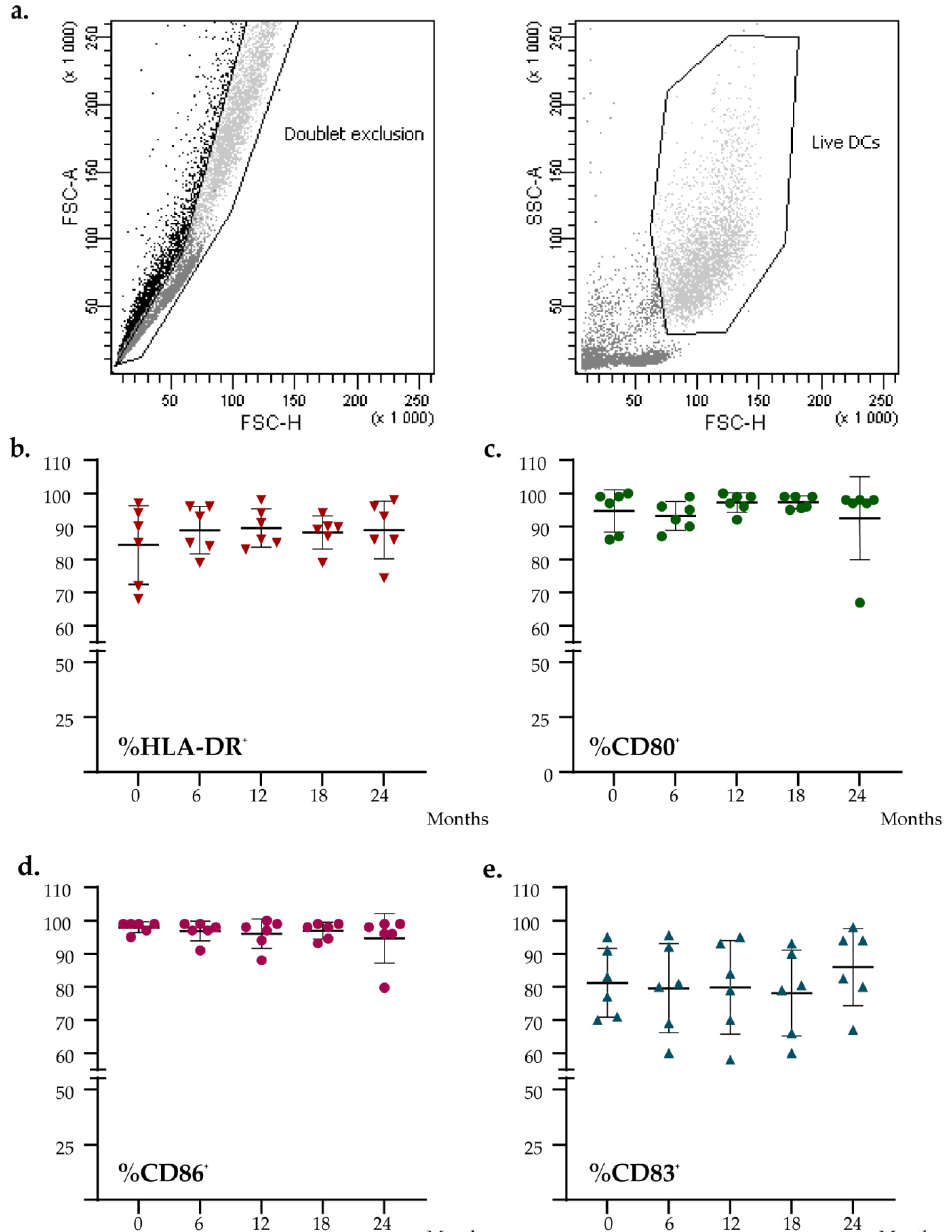
Figure 3. Flow cytometry analysis of the DCs vaccines at different time points. ( a ) Flow cytometry gating strategy. ( b – e ) Graph shows the percentage expression analysis of DCs maturation markers (HLA ‐ DR, CD80, CD86, CD83). The black lines indicate the mean percent positive for each marker.